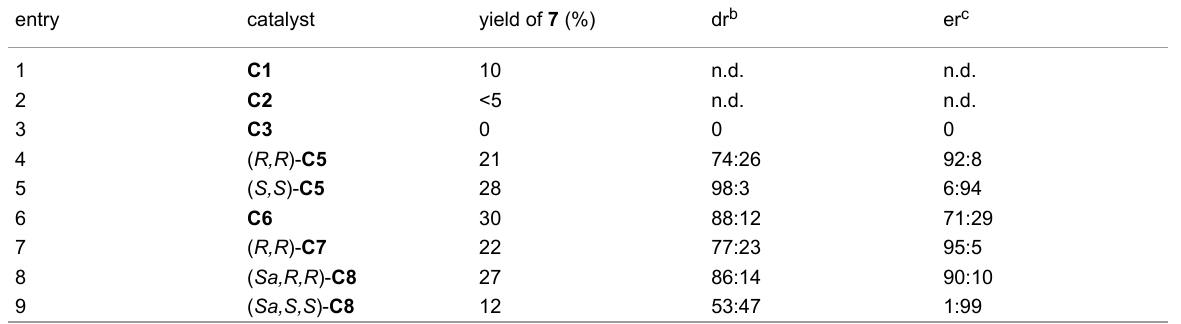
Table 1: Catalyst screening in the addition of dimethyl malonate to nitroalkene 6 . a